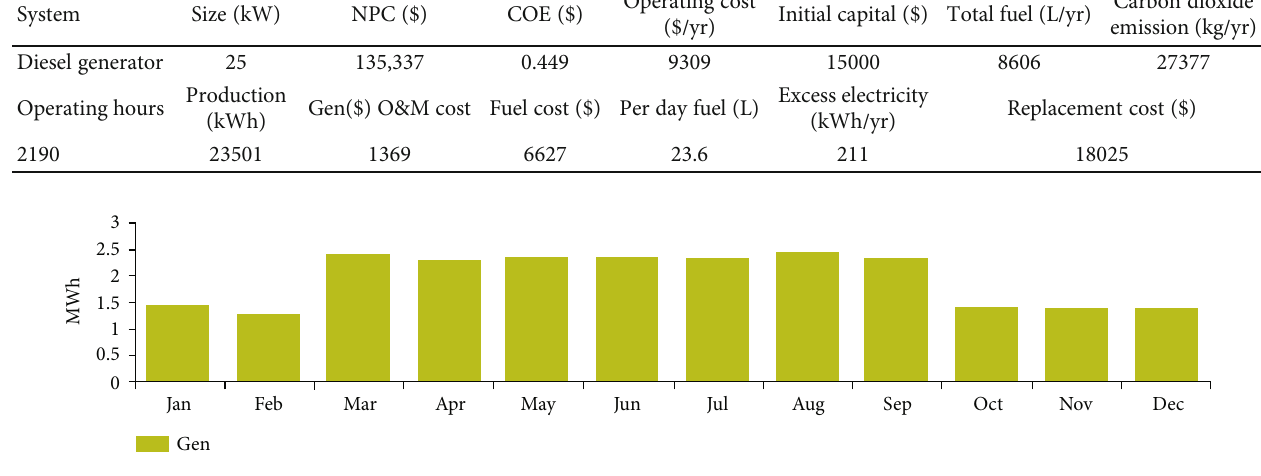
Figure 9: Monthly average electricity production of the diesel generator for the primary scenario. Table 4: Optimized cost summary of the solar-diesel-battery system for the secondary scenario.